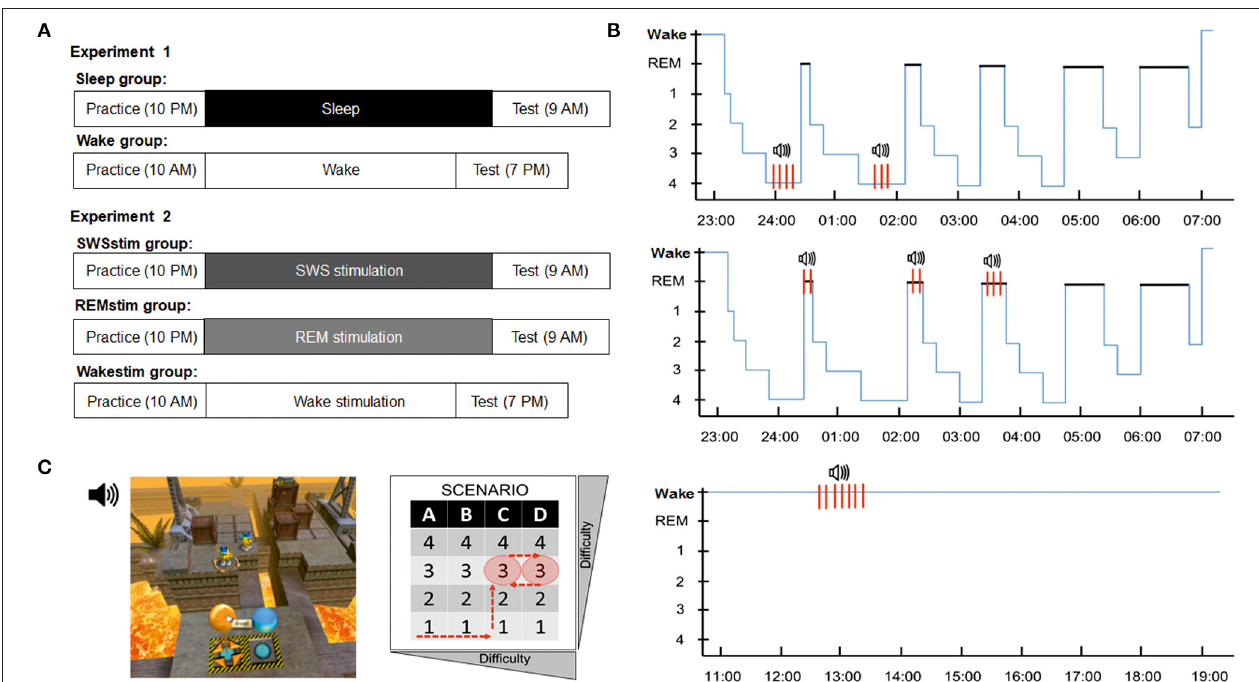
FIGURE 1 | Experimental design and procedures. (A) In Experiment 1, subjects in the Sleep group practiced the problem-solving task in the evening, spent a whole night of sleep in the lab and were tested on the task again in the morning. The Wake group practiced the problem-solving task in the morning, spent the day awake and was tested in the evening. In Experiment 2, subjects in the SWSstim group and the REMstim group practiced the task in the evening, slept a whole night in the lab with auditory targeted memory reactivation (stimulation) either during SWS or REM sleep and were tested in the next morning. Subjects in the Wakestim group practiced the task in the morning, spent the day awake while they received targeted memory reactivation, and were tested in the evening. (B) Targeted memory reactivation protocols in the SWSstim group (top), the REMstim group (middle) and the Wakestim group (bottom). (C) Visual depiction of the B-SEM task layout (left). The player controls the movement and actions of a character by mouse to reach a floating balloon that will bring him to the next level. To reach this goal the player needs to command the character to interact with different objects and tools in limited 3D scenarios. The task includes four different scenarios with increasing task difficulty, each with four difficulty levels (right). All subjects played four levels during initial practice in fixed order: level 1 of scenario A, level 1 of scenario B, level 1 of scenario C, level 2 of scenario C. Finally, subjects played level 3 of scenario C, representing the problem solving level. None of the subjects in the final analysis solved this level during practice. At testing, all subjects played two levels: the unsolved level 3 of scenario C from the practice session and the new level 3 of scenario D, with the order of levels being counterbalanced across